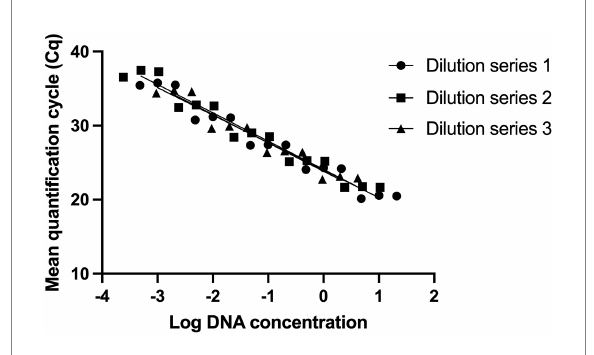
FIGURE 1 Evaluating the analytical sensitivity of Lacticaseibacillus paracasei 8700:2 strain-specific identification assay. Three DNA dilution series were prepared from starting concentrations of 10 ng/ μ l (Dilution series 1), 5 ng/ μ l (Dilution series 2), and 2 ng/ μ l (Dilution series 3). Dilution series consisted of five points each (10-fold) and each dilution was tested in triplicate to establish standard curves. The limit of detection was determined to be 0.5 pg. of DNA, corresponding to 150 target